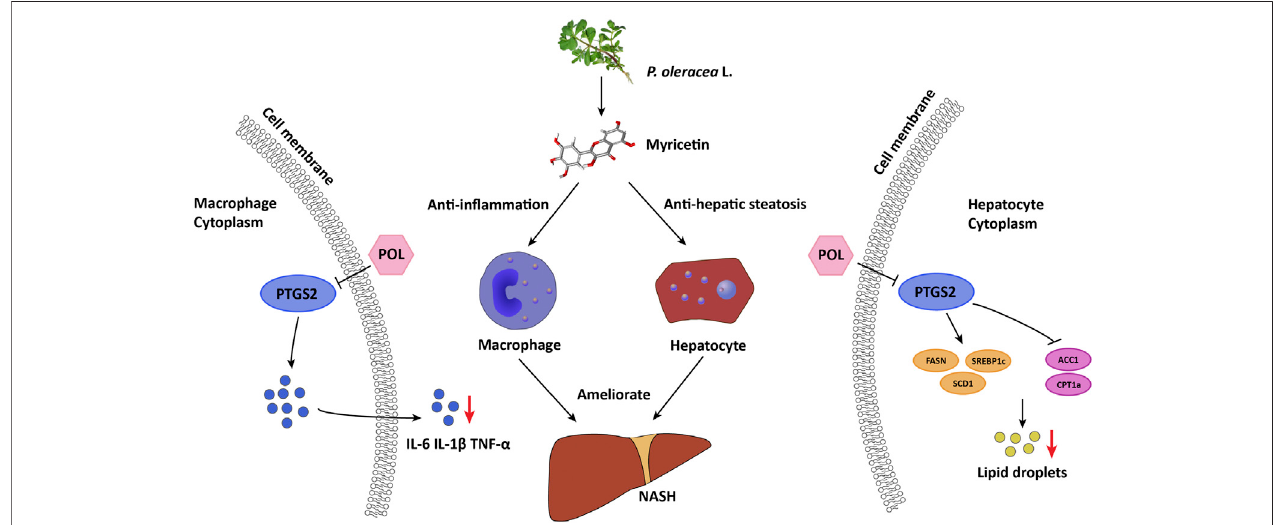
FIGURE 10 | Proposed mechanism of POL and its main active component myricetin in treating NASH through inhibiting PTGS2. In macrophages, POL and myricetin could decrease the secretion of in fl ammatory mediators such as IL-6, IL-1 β , and TNF- α through down-regulating PTGS2. In hepatocytes, POL and myricetin could regulate lipid synthesis and homostasis by down-regulating FASN, SREBP1c, and SCD1 and up-regulating ACC1 and CPT1a through inhibiting PTGS2. Thus, POL could reduce lipid accumulation of hepatocyte and inhibit hepatic in fl ammation to treat